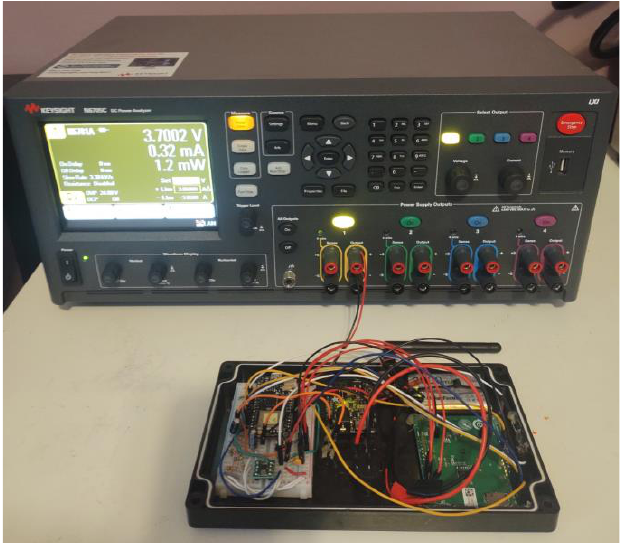
Figure 15. Experimental setup for measuring current consumption of the sensor node using the Keysight N6705C DC power analyzer.